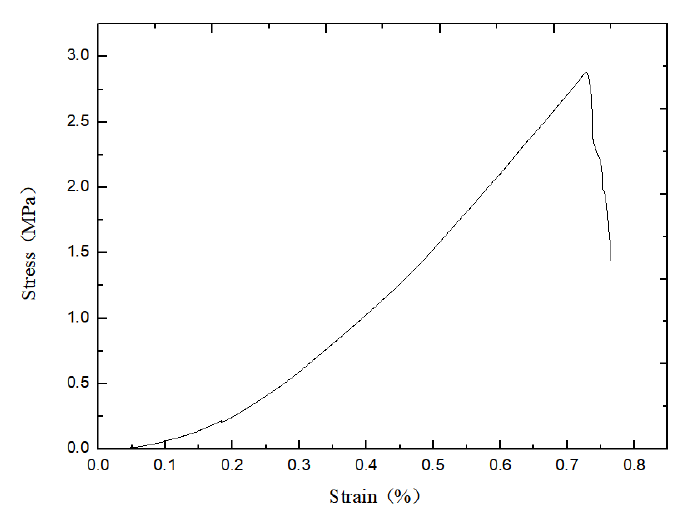
Figure 11. Numerical simulation of Brazilian splitting experiment.